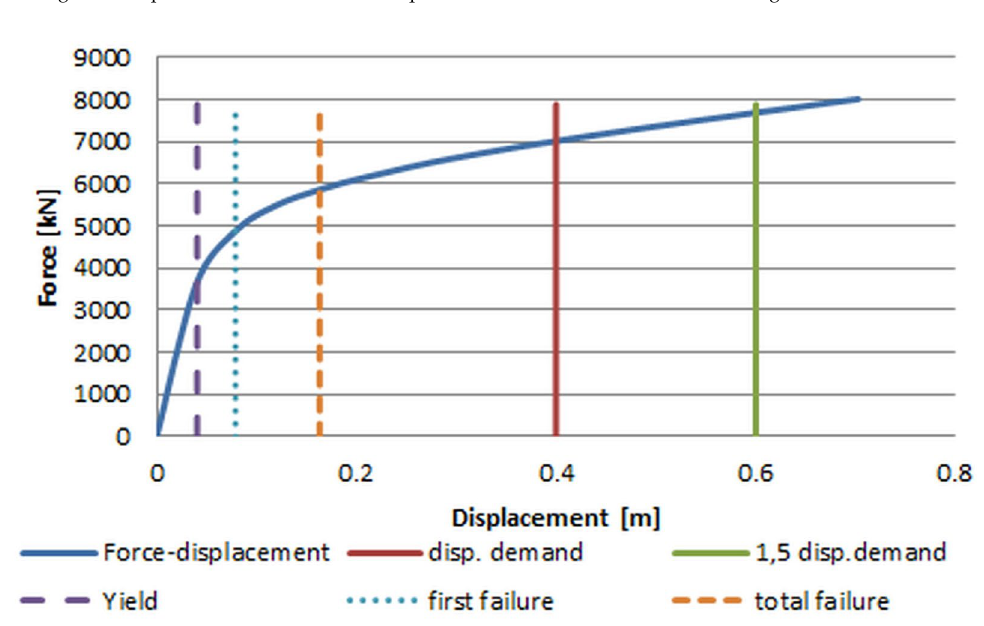
Table 3. Details regarding the force–displacement curve shown in Figure 8.